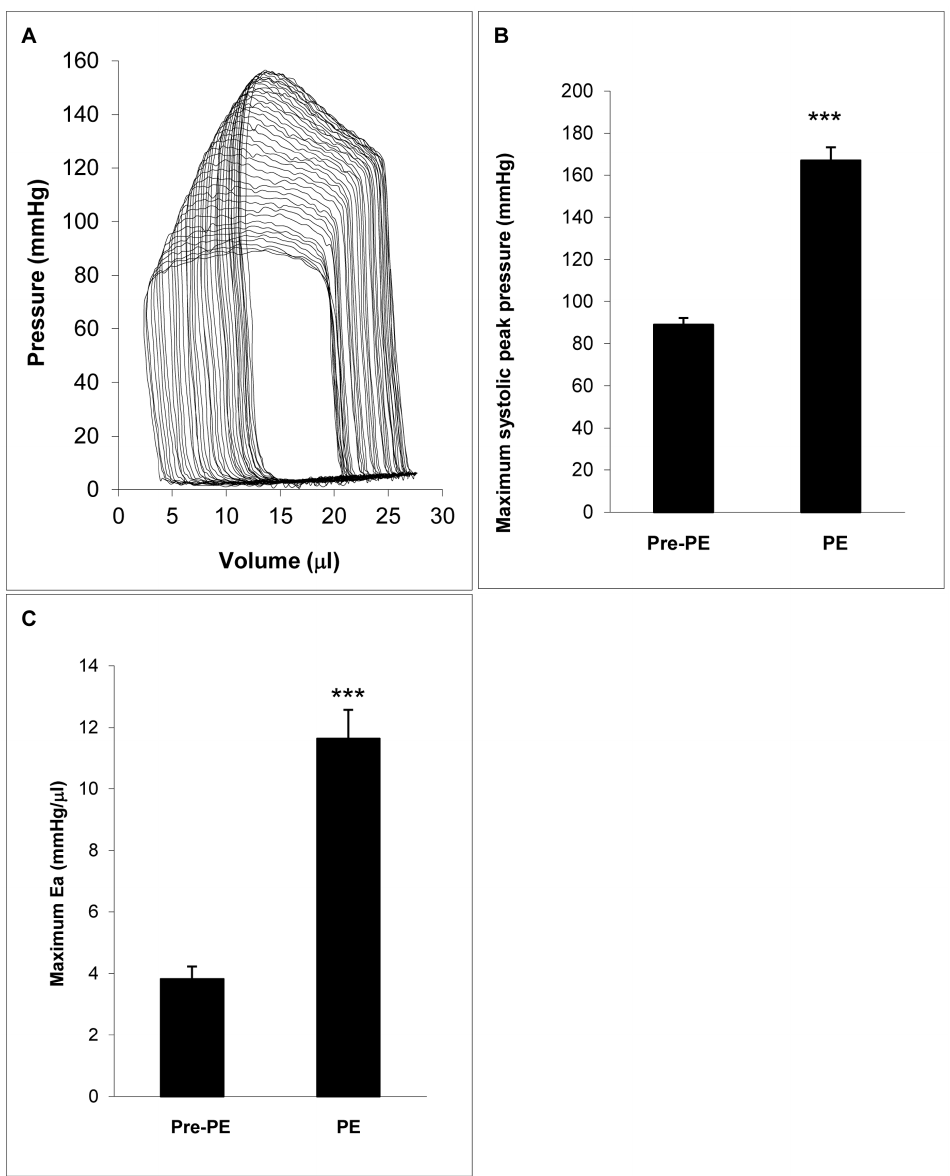
Figure 1. Arterial load was acutely increased by phenylephrine intravenous administration. A: Real time recording of series of pressure- volume loops during phenylephrine injection by Millar conductance catheter. The mean systolic peak pressure (B) and the mean arterial load (Ea) (C) of 10 mice were calculated before phenylephrine injection (Pre-PE) and at the maximum effects of phenylephrine (PE). PE=phenylephrine, Ea (effective arterial elastance)=Pes/SV (end systolic pressure/stroke volume).